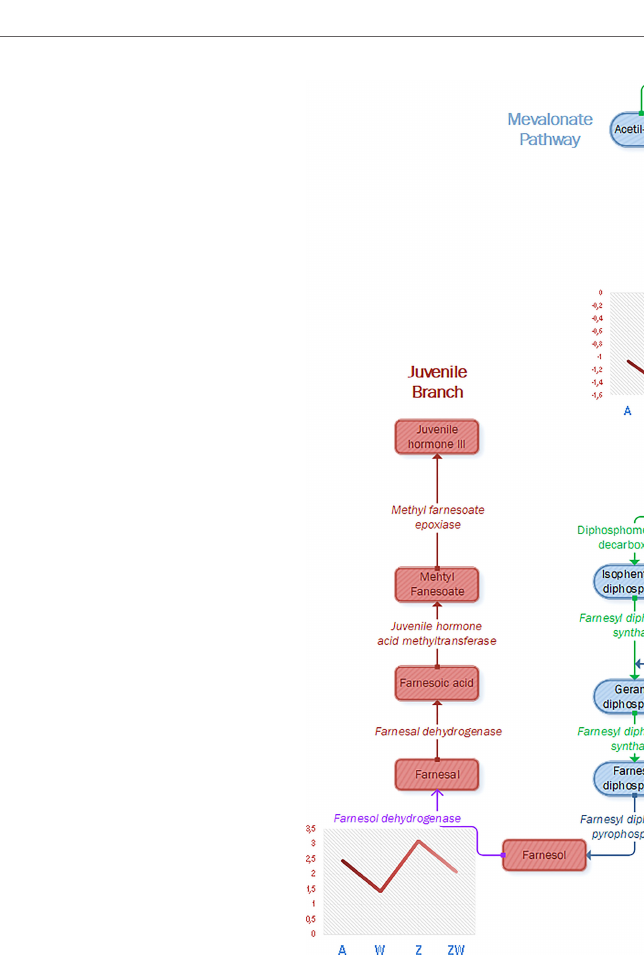
FIGURE 3 | Identi fi cation and modulation of proteins that participate in the JH pathway, composed of the mevalonate pathway (early step), represented in gray, and juvenile hormone branch (last step), represented in blue, and juvenile hormone branch (last step), represented in red (pathway adapted from Nouzova et al., 2011). Enzymes colored in green were identi fi ed in Ae. aegypti proteome in this work, and enzymes colored in purple were identi fi ed and quanti fi ed as modulated during ZIKV or Wolbachia infection. Mevalonate kinase and farnesol dehydrogenase were downregulated in Wolbachia infection and farnesol dehydrogenase was upregulated in ZIKV infection, as represented in graphs containing each condition and the respective fold change of each modulated